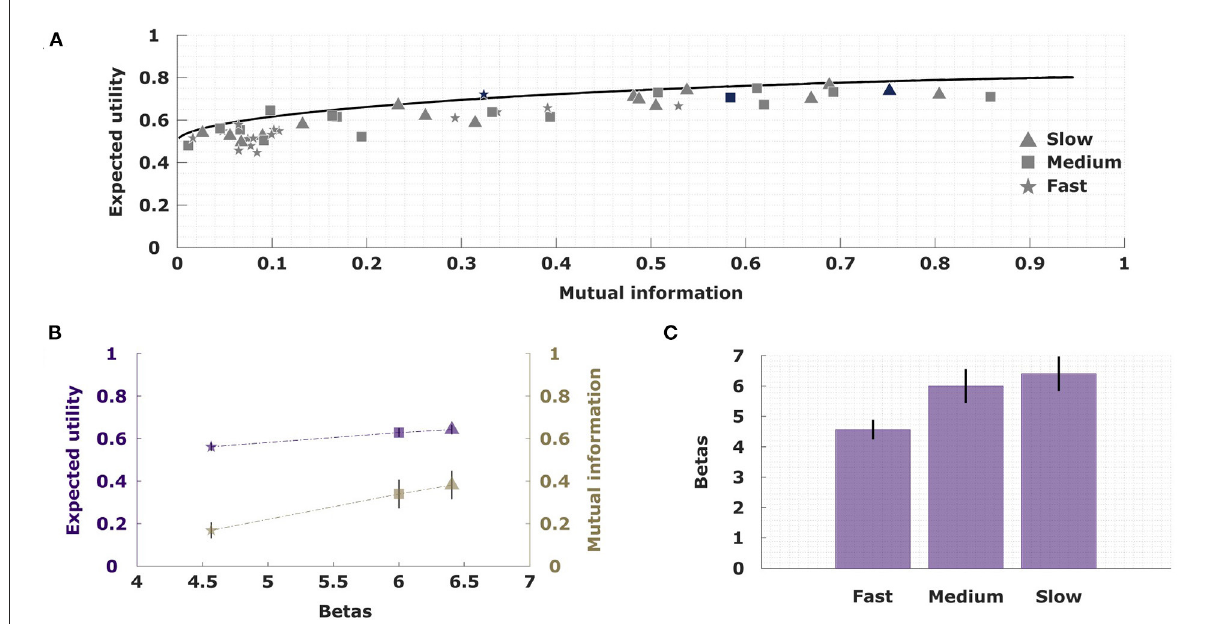
FIGURE7 The information-utility trade-off. (A) All participants perform close to the optimal information-utility curve (analogous to the rate-distortion curve in information theory). An exemplary participant is highlighted. (B) Values of expected utility and mutual information when fitting subjects’ behavior with a single information channel model across the three different conditions. (C) The precision parameter β that is fitted across the three conditions shows a direct relationship with increasing